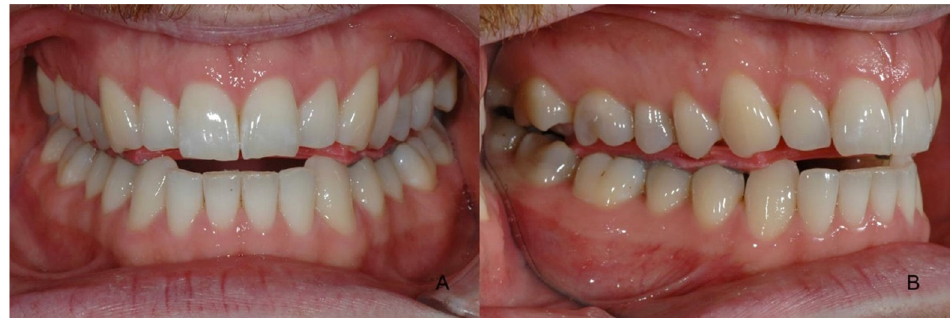
Figure 1. The fixed OVD with a wax plate and Aluwax from the frontal ( A ) and side aspects ( B ).